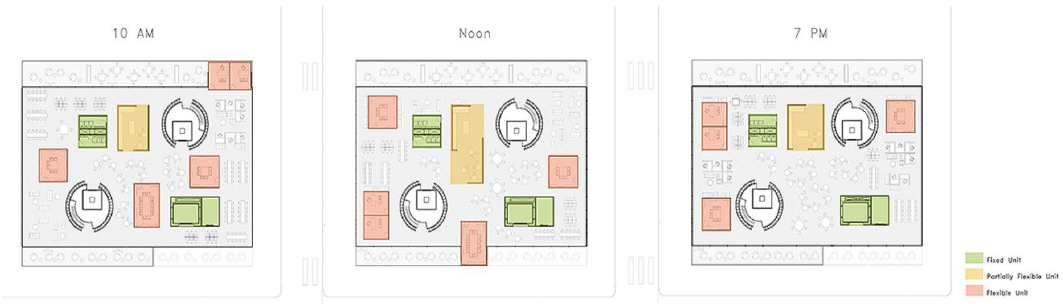
Figure 14 Plan diagram from Chaillou's project Metabolism (S), inspired by the Nakagin Capsule Tower (Archdaily, McManus,